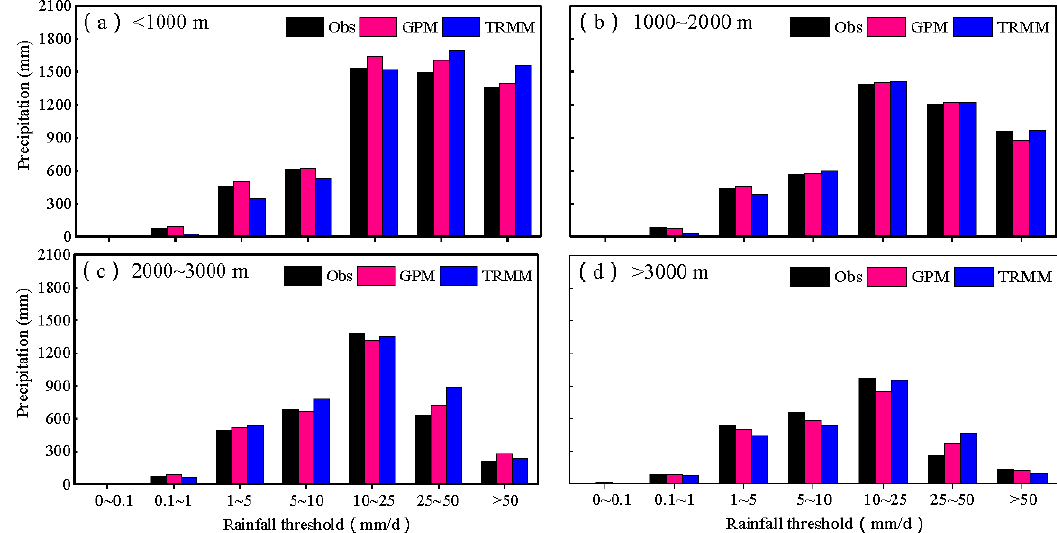
Figure 10. The mean rainfall at different precipitation thresholds of IMERG v5 and 3B42 v7 at different altitudes. ( a ): < 1000 m; ( b ): 1000~2000 m; ( c ): 2000~3000 m; ( d ): > 3000 m)